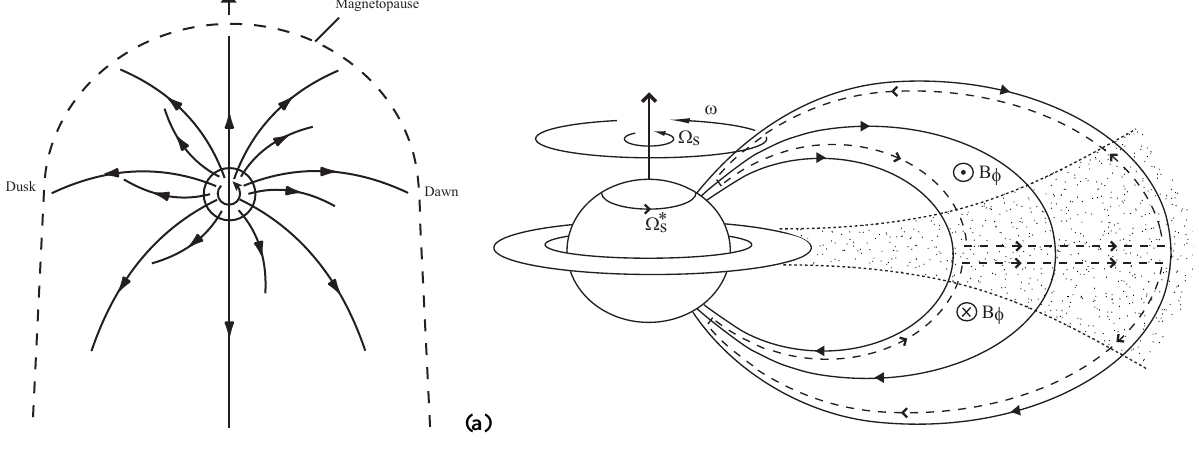
Fig. 1. (a) Sketch looking down onto the northern pole of Saturn, showing field lines (arrowed solid lines) projected onto the equatorial plane. The sense of planetary rotation is anti-clockwise, as indicated. The inner field lines are shown bent into a ‘lagging’ configuration associated with angular momentum transfer from the atmosphere to the magnetosphere due to sub-corotation of the magnetospheric plasma. The outer field lines are shown bent away from noon, due to the effect of the magnetopause (solid line) and tail current system. (b) Sketch of a meridian cross section through Saturn’s quasi-axisymmetric inner and central magnetosphere, extending to distances of ∼ 15–20 R S in the equatorial plane. The arrowed solid lines indicate magnetic field lines, which are modestly distended outward from the planet by azimuthal currents (the ‘ring-current’) flowing in the near-equatorial plasma. The rotating plasma is shown by the dotted region, consisting mainly of protons and oxygen ions and associated electrons, which derive from water ice originating from ring grains and moon surfaces. Three separate angular velocities are indicated. These are the angular velocity of a particular shell of field lines ω , the angular velocity of the planet (cid:127) S , and the angular velocity of the neutral upper atmosphere in the Pedersen layer of the ionosphere, (cid:127) ∗ . The value of (cid:127) ∗ is expected to lie S S between ω and (cid:127) S because of the frictional torque on the atmosphere due to ion-neutral collisions. The oppositely-directed frictional torque on the magnetospheric flux tubes is communicated to the equatorial plasma by the current system indicated by the arrowed dashed lines, shown here for the case of sub-corotation of the plasma (i.e. ω < (cid:127) S ). This current system bends the field lines out of meridian planes into a ‘lagging’ configuration, as shown by the inner field lines in (a), associated with the azimuthal field components B ϕ , as